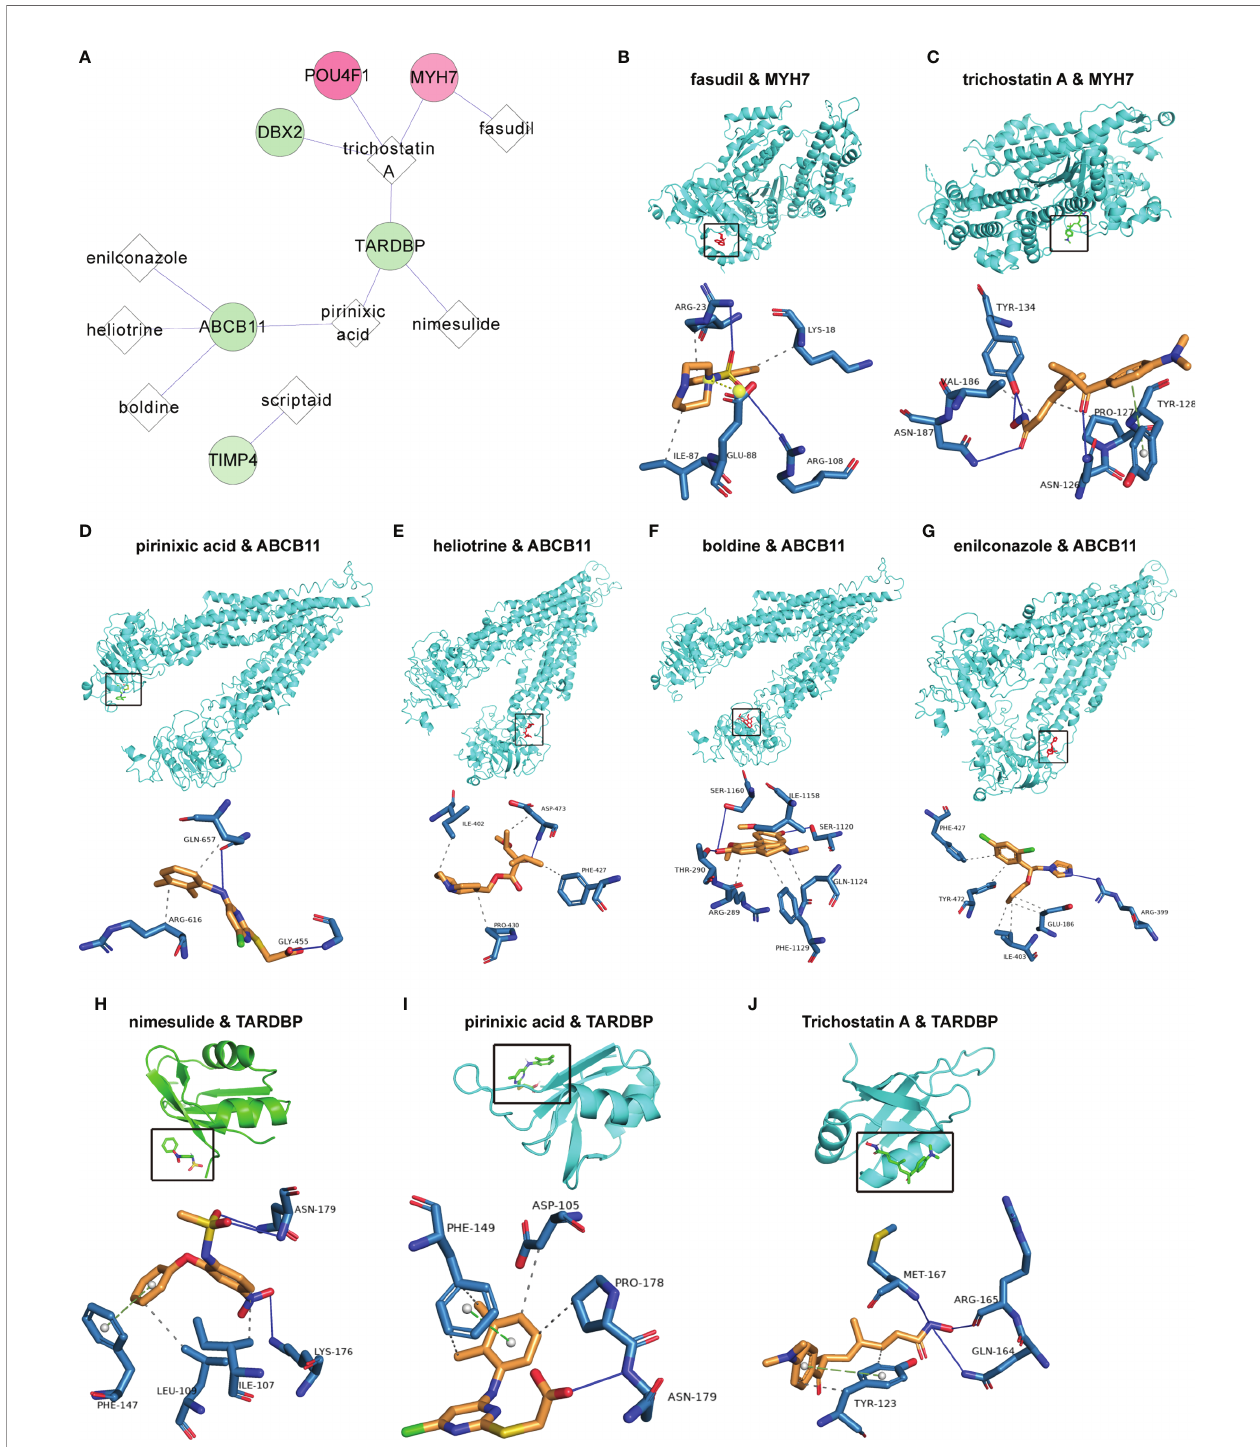
FIGURE 7 | Correlation of the PS model characteristic features with small-molecule inhibitors. (A) Network of the associations of characteristic factors with small-molecule drugs. The circles and diamonds represent genes and drug molecules, respectively. (B – J) Molecular docking global diagram. Fasudil binding to MYH7 (B) , trichostatin A binding to MYH7 (C) , pirinixic acid binding to ABCB11 (D) , heliotrine binding to ABCB11 (E) , boldine binding to ABCB11 (F) , enilconazole binding to ABCB11 (G) , nimesulide binding to TARDBP (H) , pirinixic acid binding to TARDBP (I) and trichostatin A binding to TARDBP (J) are